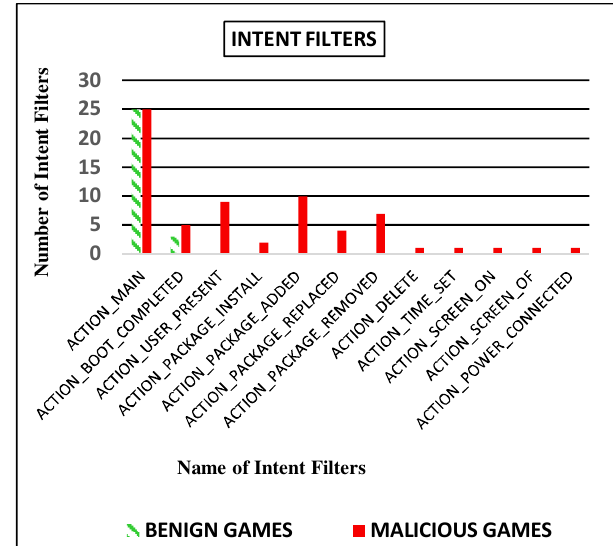
Fig. 10: Comparison of Requested Intent